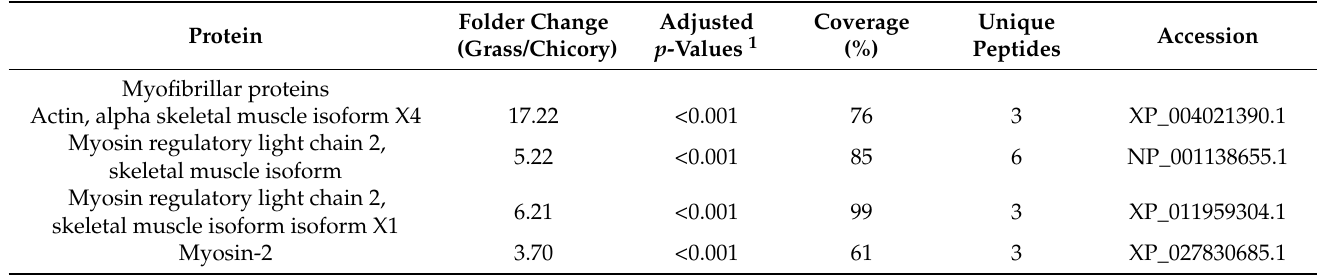
Table 4. Identified myofibrillar proteins that significantly differed between raw lamb longissimus lumborum muscle from 6- to 8-month-old ewe lambs grazed on perennial ryegrass and chicory. n = 6 for GRASS-W and n = 6 for CHIC-W.